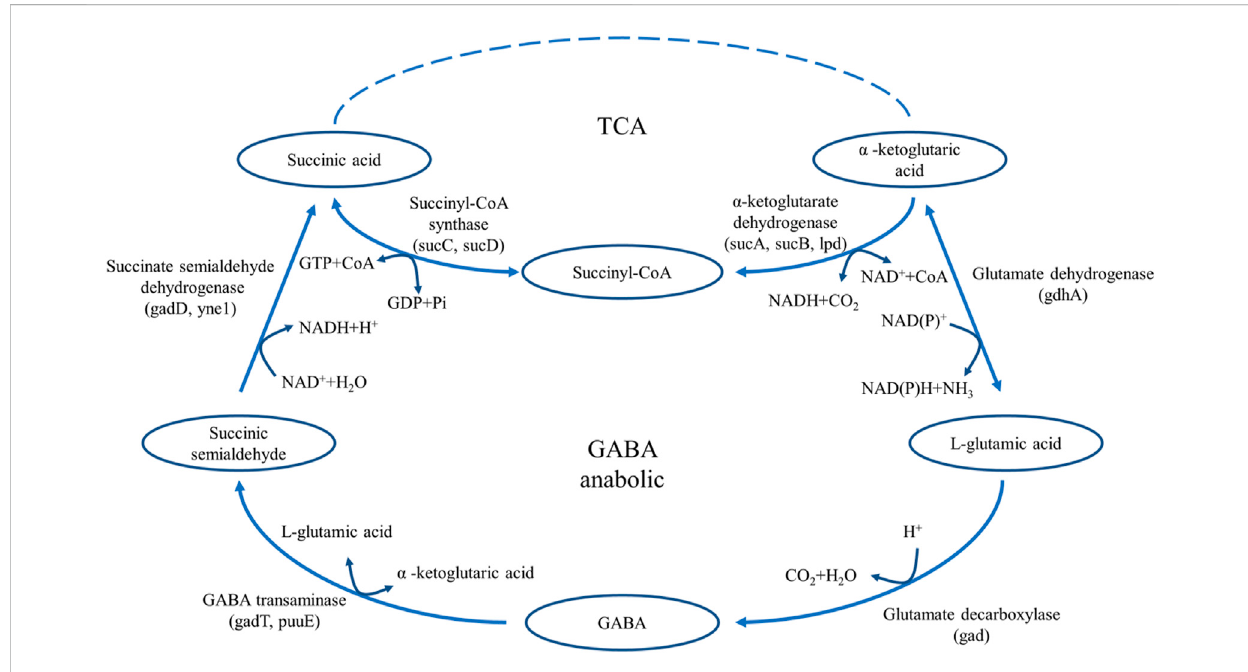
FIGURE 1 The pathway of GABA synthesis and metabolism in E. coli